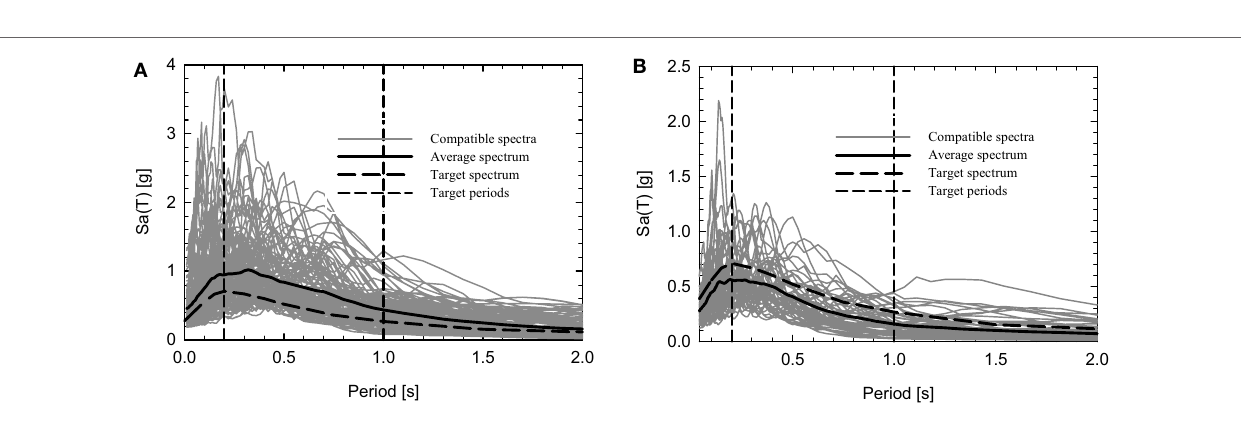
FigUre 8 | Multi period matching with uniform hazard spectrum as target spectrum, for the (a) Peer database and (B) esMD .